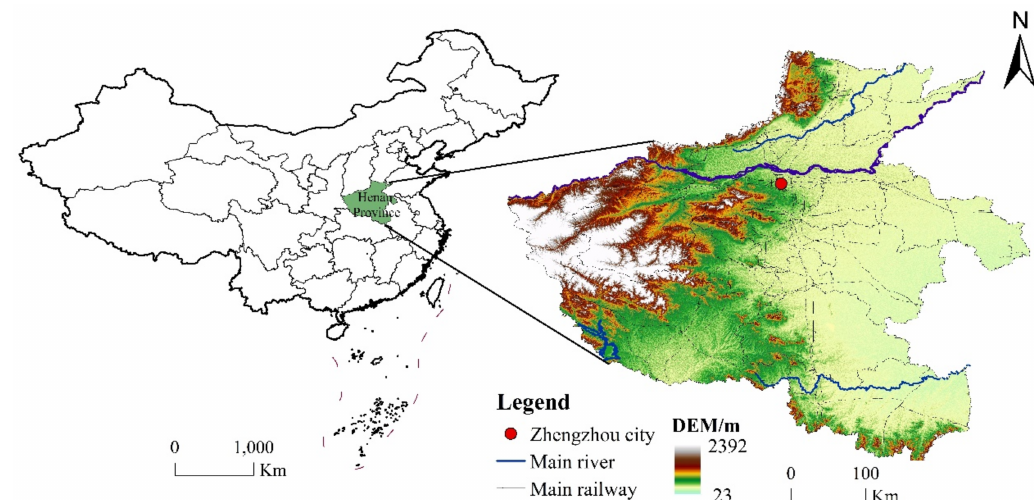
Figure 1. Location and topography of Henan